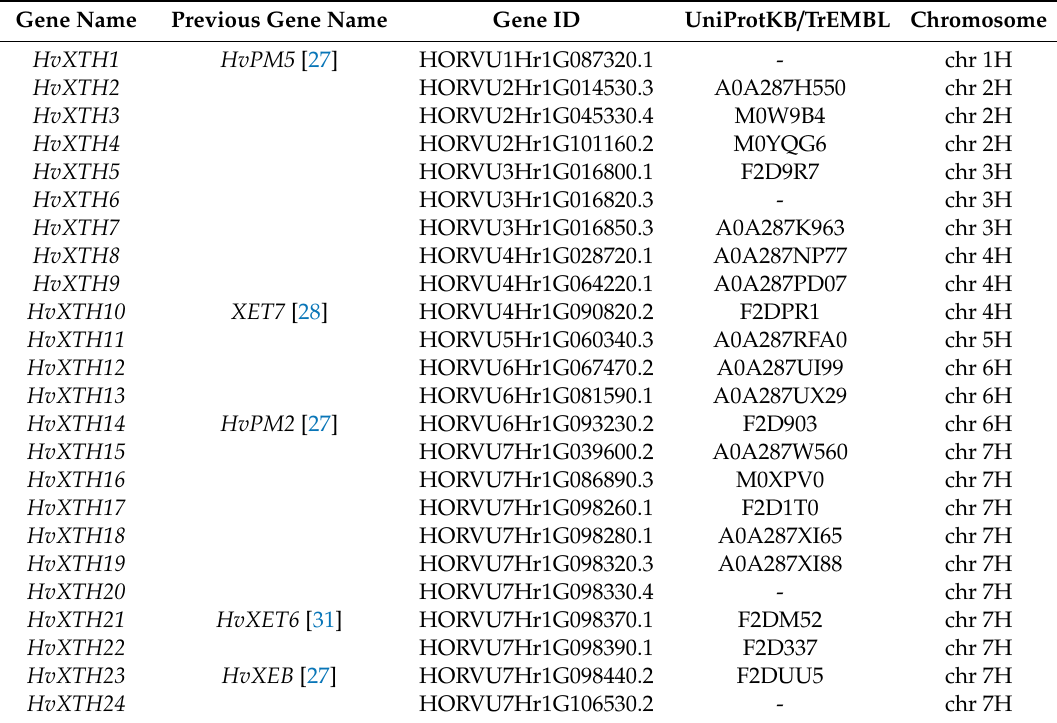
Table 1. XTH genes identified in barley